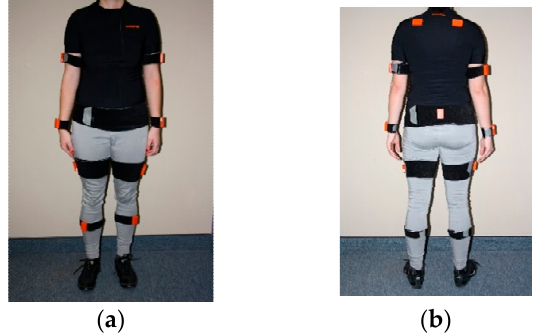
Figure 1. Sensors placement example, ( a ) front view, ( b ) back view.